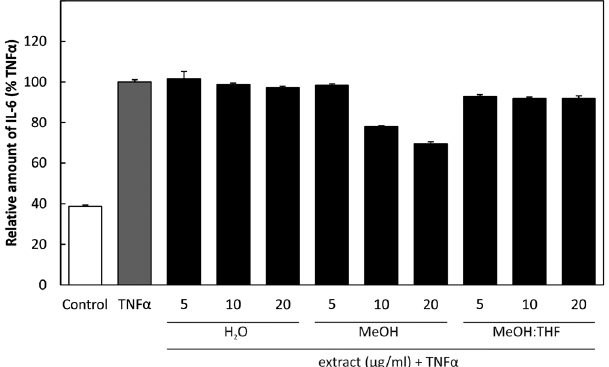
Figure 2. IL-6 ELISA: A sandwich ELISA was used to determine IL-6 production by HUVEC in the cultivation medium after pre-stimulation with 5, 10 and 20 µ g/ml of extracts for 30 min and activating with TNF α for 24 hours.